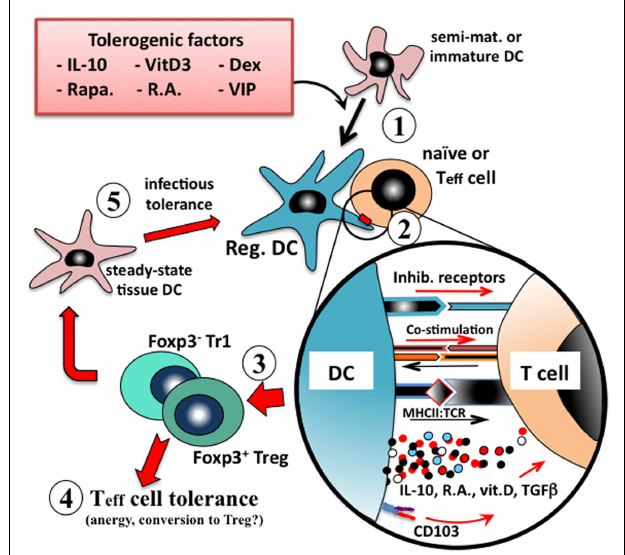
FIGURE 1 | Induction of immunologic tolerance by regulatory dendritic cells . Immature or semi-mature dendritic cells that are incubated with, or differentiated in the presence of, tolerogenic factors (e.g., IL-10, vitamin D3, corticosteroids, or retinoic acid) (1) adopt a regulatory phenotype.When these converted regulatory dendritic cells are pulsed with antigen and exposed to cognate naïve or effectorT (Teff) cells (2), they present their processed antigen peptides in the context of MHCII, and also lower levels of co-stimulation (e.g., CD40, CD86) to theT cells, but at the same time many types of tolerogenic cells also provide inhibitory receptor (e.g., ILT2, ILT4) signaling to theT cell. Counter-signaling from the engagedT cell activates dendritic cell production of polarizing mediators (e.g., IL-10,TGF β ), which together instruct theT cell to adopt a regulatory phenotype.The nature of the instructional signals from the dendritic cell to theT cell determine whether it adopts an IL-10-secreting CD25 + Foxp3 + Treg phenotype or an IL-10/TGF β -secreting Foxp3 − Tr1 phenotype (3).These regulatoryT cells are able to suppress the responses of cognate or by-stander naïve or effectorT cells in their microenvironment (4) and also to convert endogenous tissue dendritic cells to adopt a regulatory phenotype through induction of infectious tolerance (5), and thereby reinforce the tolerance